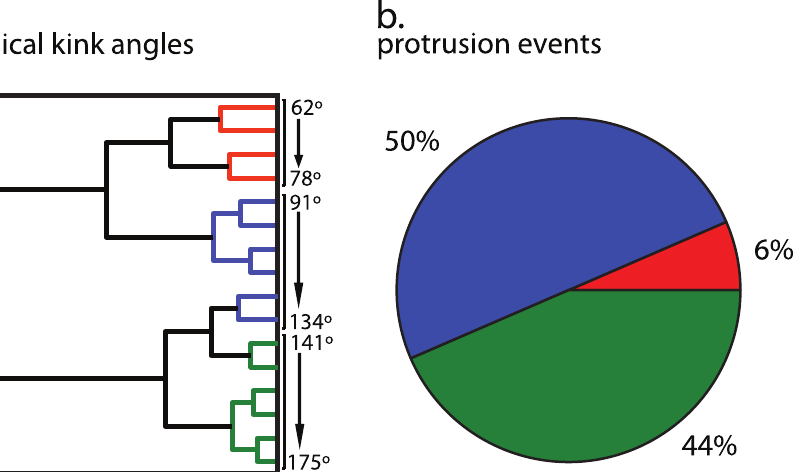
Figure 6. Protrusion events mapped to fusion peptide conformation for the unrestrained G1V-mutant simulation. Clustering (a), mapping (b) and classification was performed as in Fig. 5. Similar to the X-31 peptide (Fig. 5), the majority of protrusion events occur near a kinked helix (50%) followed by 44% close to more shallow kink-angles, and 6% around hairpin-like structures. The lower overall likelihood of a kinked helix conformation for the G1V mutant peptide may explain the lower protrusion